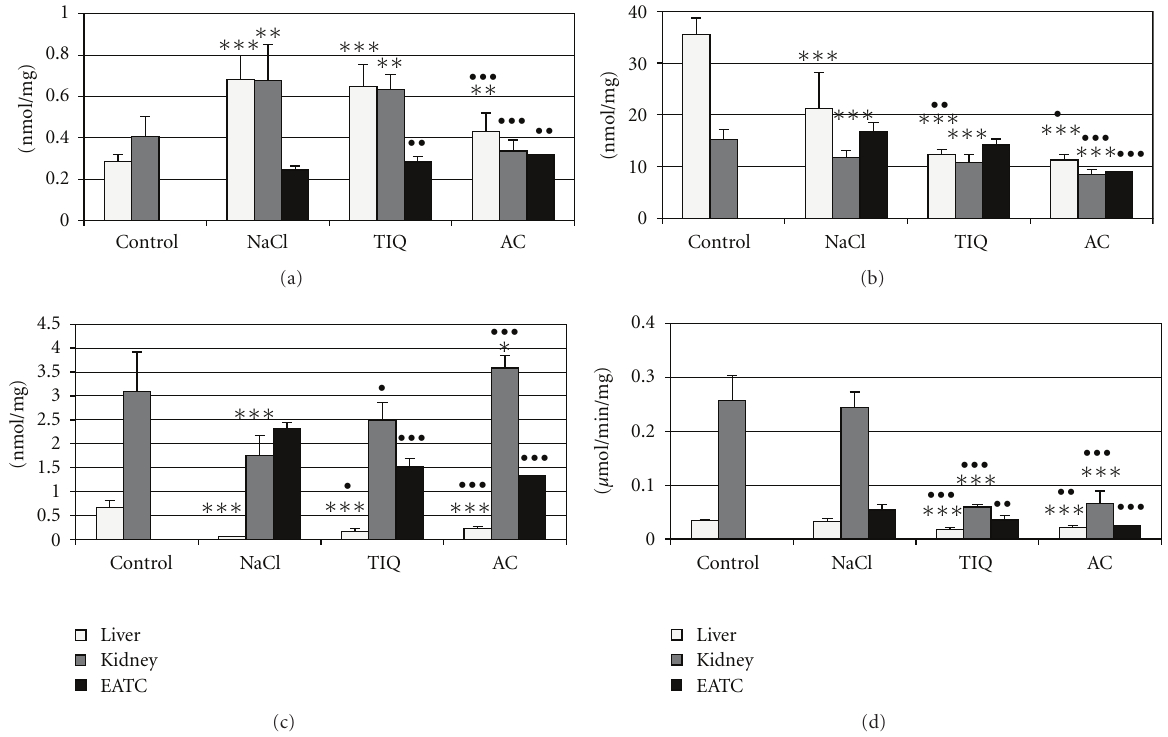
Figure 1: Reactive oxygen species (a), nonprotein sulfhydryl groups (b), cysteine (c) level, and γ -glutamyltranspeptidase activity (d) in healthy and Ehrlich ascites tumor- (EAT-) bearing mice livers, kidneys, and EAT cells. 0.9% NaCl (control groups), 1,2,3,4- tetrahydroisoquinoline (TIQ) at 50 mg · kg − 1 of body weight, and acivicin (AC) at 18 mg · kg − 1 were i.p. injected for 5 days. ∗ - P < 0 . 05 versus control, ∗∗ - P < 0 . 01 versus control, ∗∗∗ - P < 0 . 001 versus control, • - P < 0 . 05 versus NaCl, •• - P < 0 . 01 versus NaCl, ••• - P < 0 . 001 versus